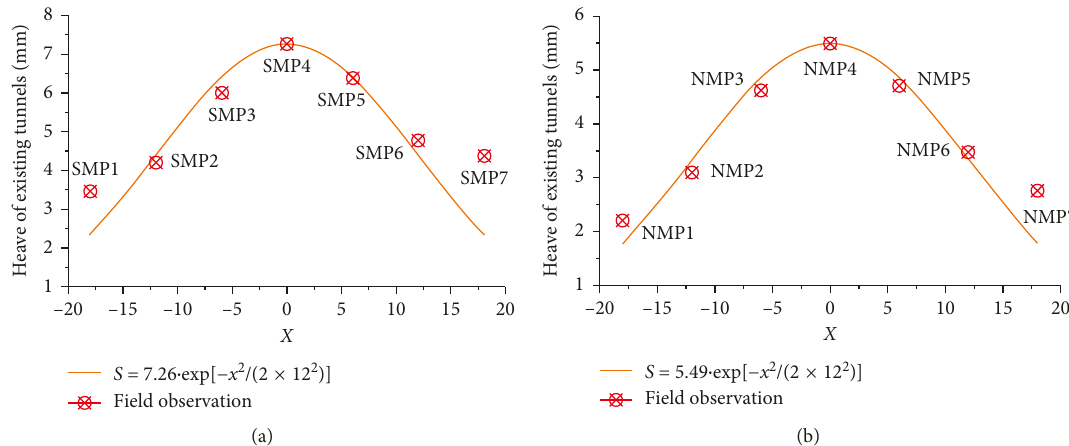
Figure 21: Calculation results and heave of existing tunnels: (a) calculation results and heave value of SMP1 ∼ 7; (b) calculation results and heave value of NMP1 ∼ 7.